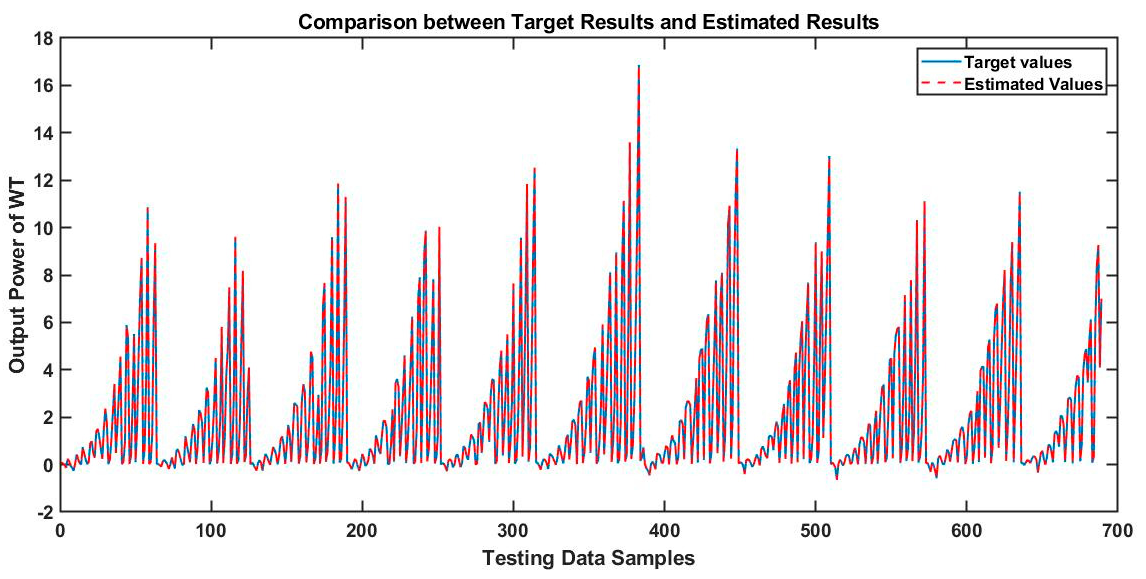
Figure 9. Comparison between target values and estimated values for FFBPNN (case 2).